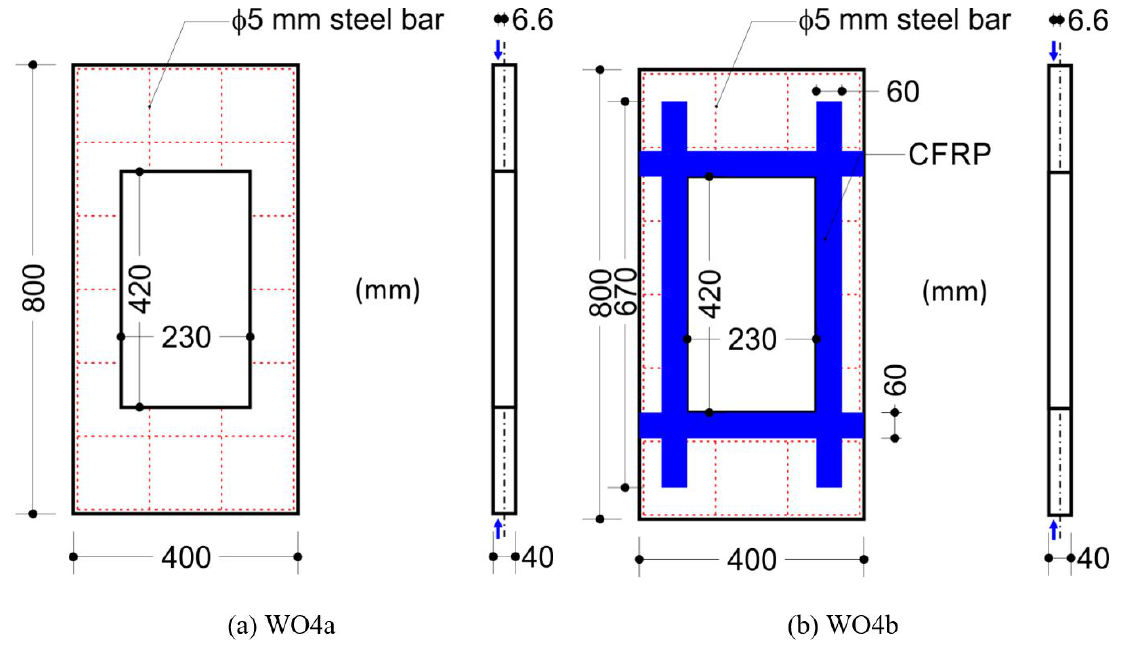
Figure 3. Dimensions, rebar layout and CFRP strengthening of the experimental RC